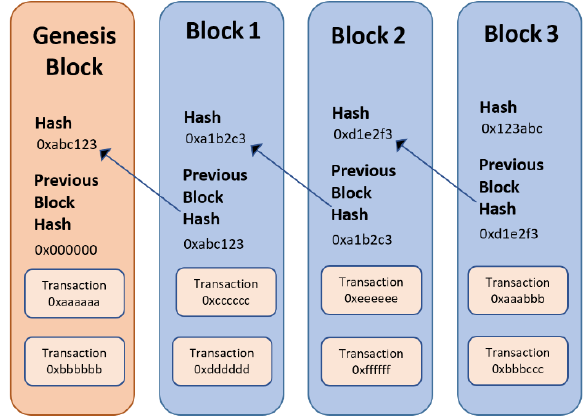
Figure 2. Blockchain and Hashing